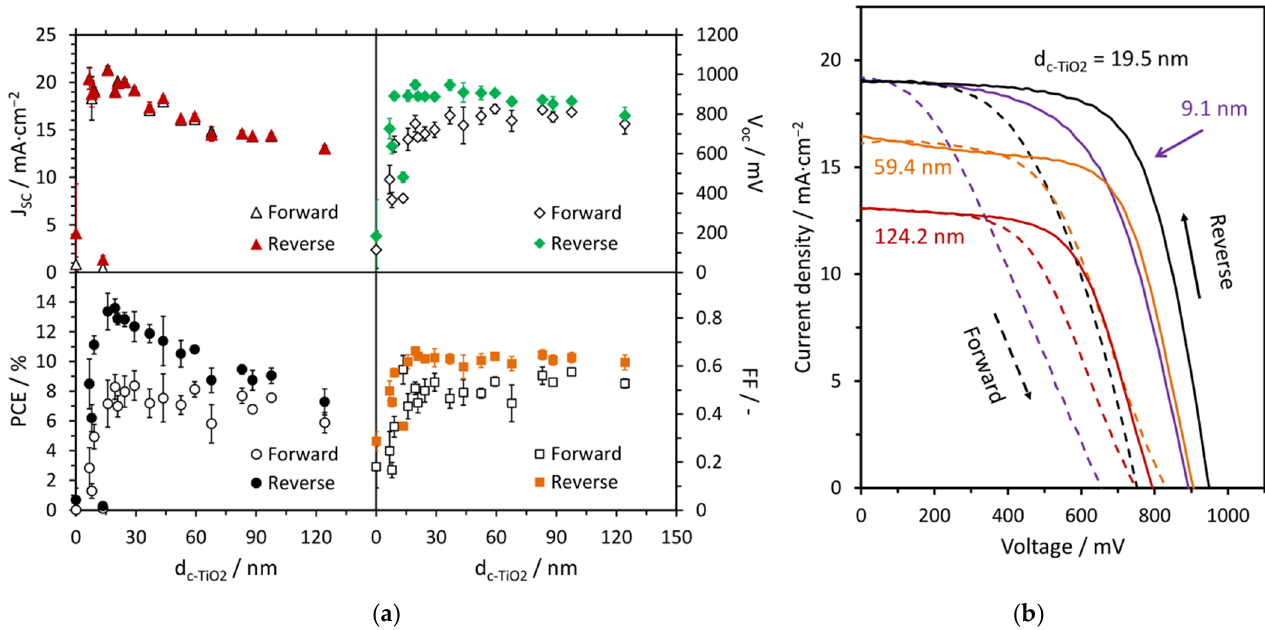
Figure 5. ( a ) Influence of the c-TiO 2 layer thickness on basic photoelectric parameters: short-circuit current density (J SC ), open-circuit voltage (V OC ), power conversion efficiency (PCE) and fill factor (FF). ( b ) Averaged current density–voltage (J–V) curves for the selected cells with different c-TiO 2 thicknesses (scan speed = 1V/s, light soaking 10 s before measure- ment).